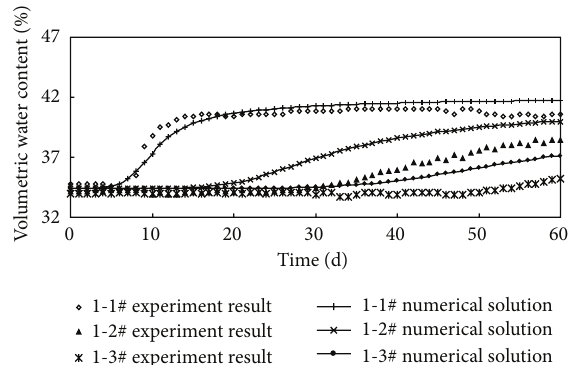
Figure 12: Comparison of calculated subgrade moisture with experimental results in Stage 1.